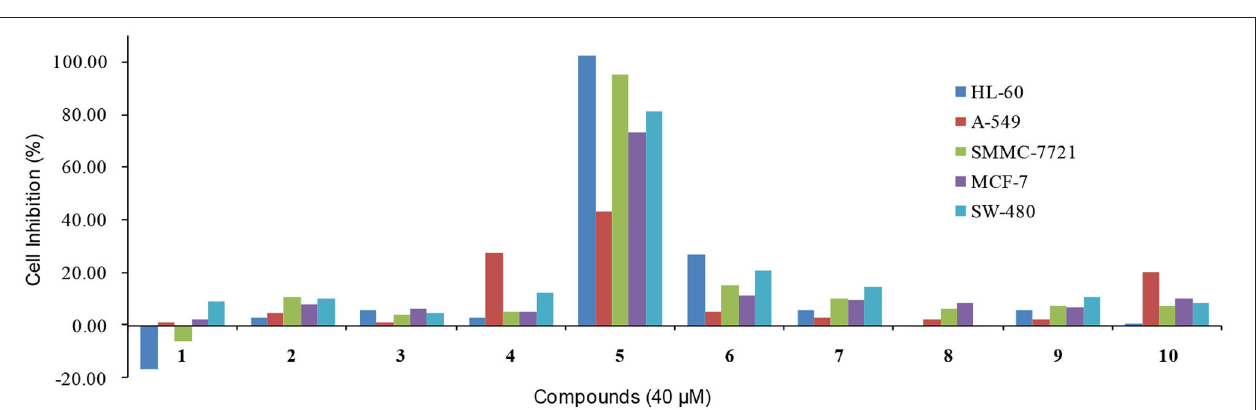
FIGURE 12 | The cytotoxic activities against five human cancer cell lines of compounds 1 - 10.